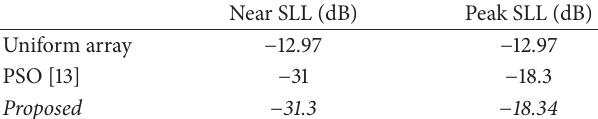
Table 9: Near SLL and peak SLL for Example 4 .